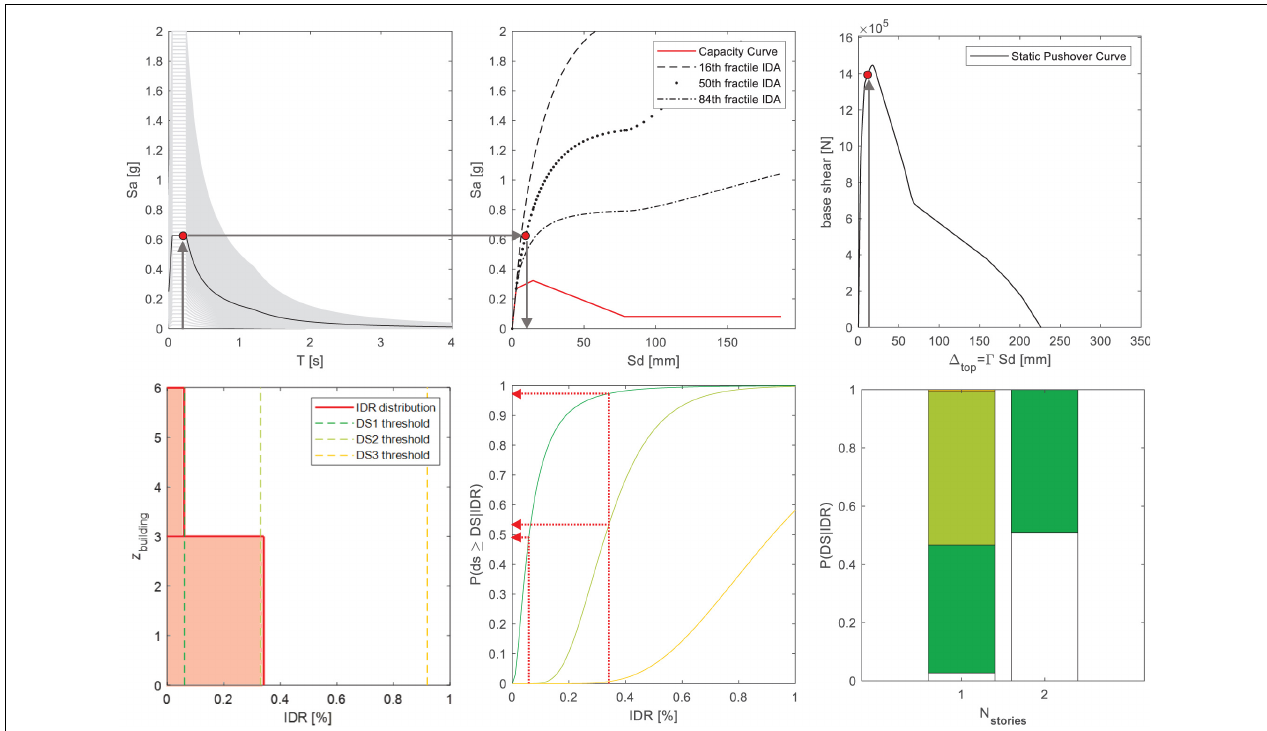
FIGURE 7 | Damage assessment procedure (example shown for a two-story building in the X